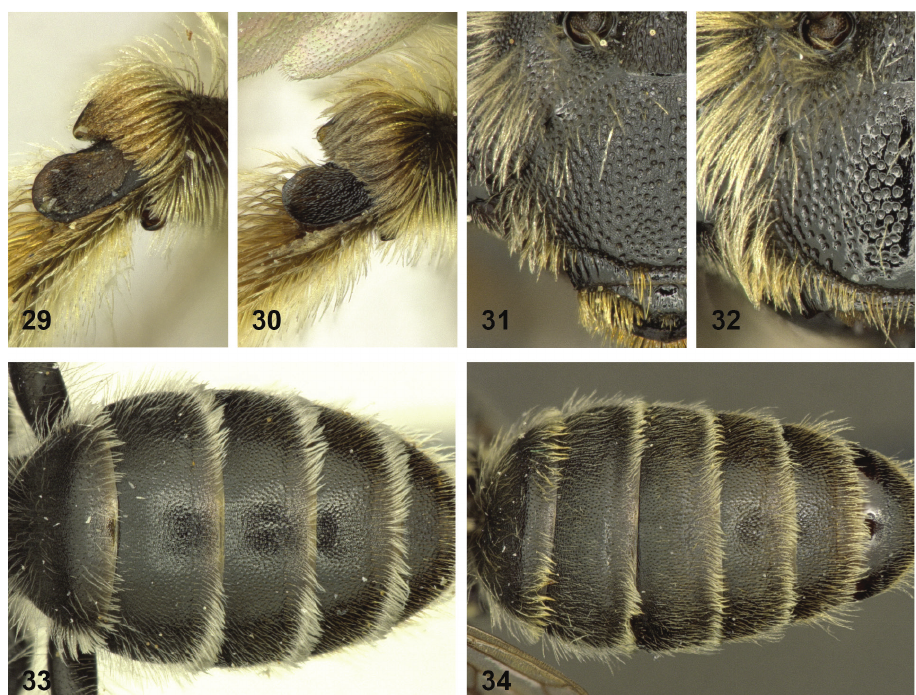
Figures 29–34. 29, 30 apical fringe of hairs on femur, covering the base of basitibial plate in females 29 Andrena afzeliella 30 A. ovatula 31, 32 Female clypeus 31 A. afzeliella 32 A. ovatula 33, 34 male metasoma 33 A. afzeliella 34 A. ovatula